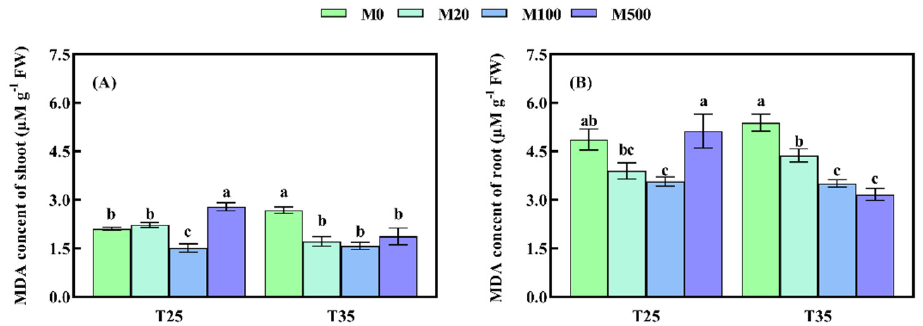
Figure 5. Effects of exogenous melatonin on MDA content in rice shoots and roots under drought stress. Means ± SEs with different letters in each parameter indicate significant statistical differences (LSD, 0.05). ( A ) MDA content of shoot; ( B ) MDA content of root.